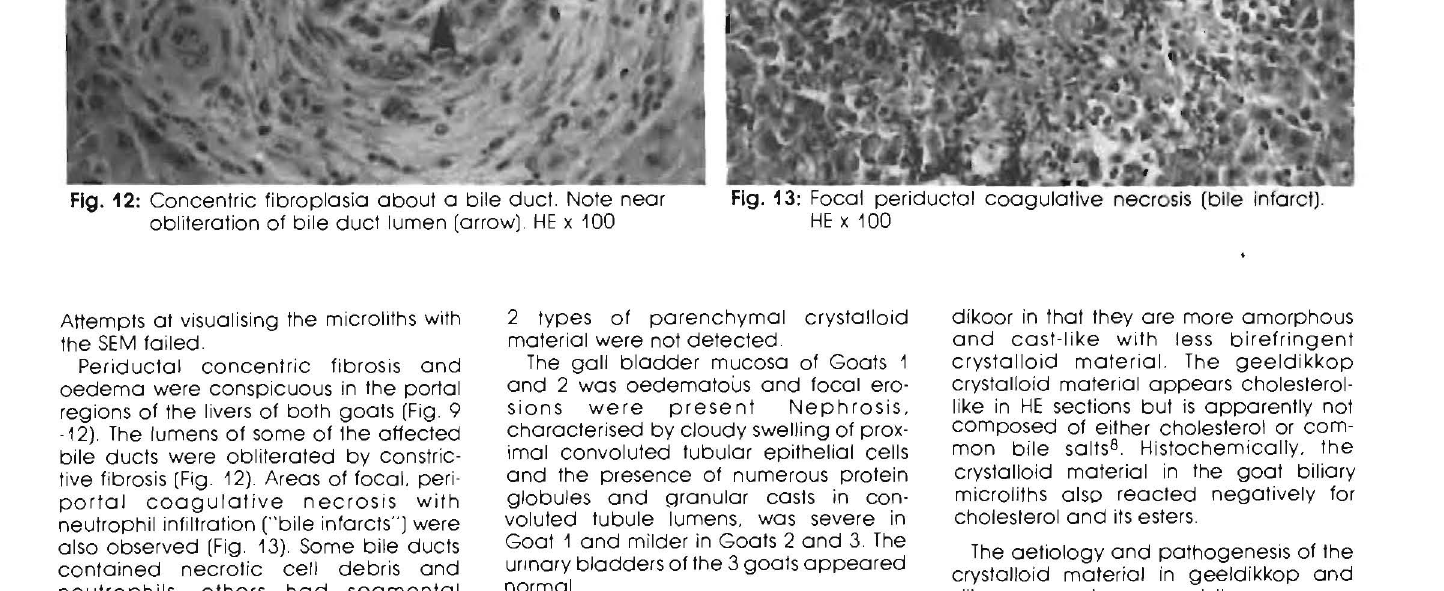
Fig. 13: Focal periductal coagulative necrosis (bile infarct).